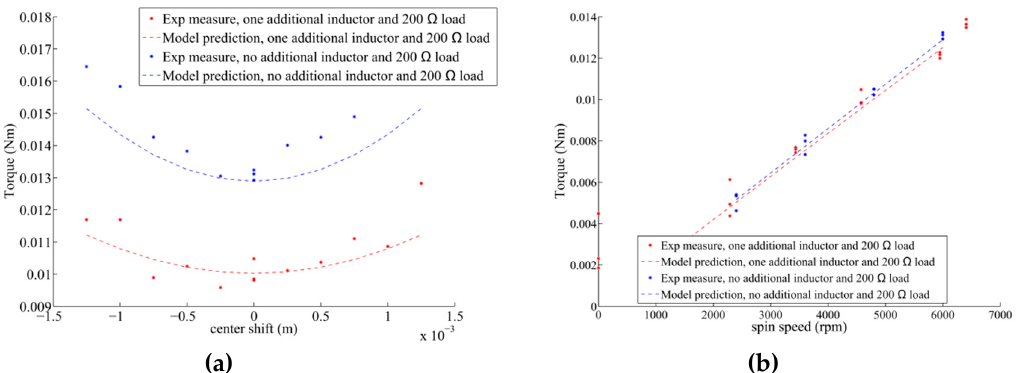
Figure 24. Measured and predicted torque, when the generator is connected to a 200 Ω charge ( a ) as a function of the rotor displacement along the x-axis while centered along the y-axis for a spin speed of 6000 rpm and ( b ) as a function of the spin speed when the rotor is centered. Measurements were conducted with and without external inductors.